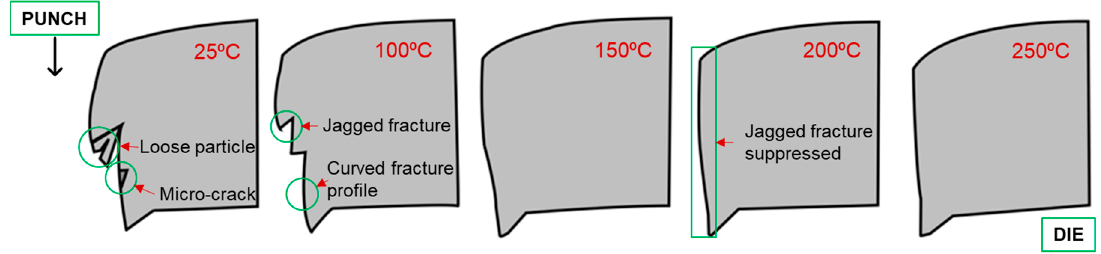
Figure 15. Schematic comparison of sheared edge profiles at temperatures ranging from 25–250 °C and punch–die clearance of 20%.